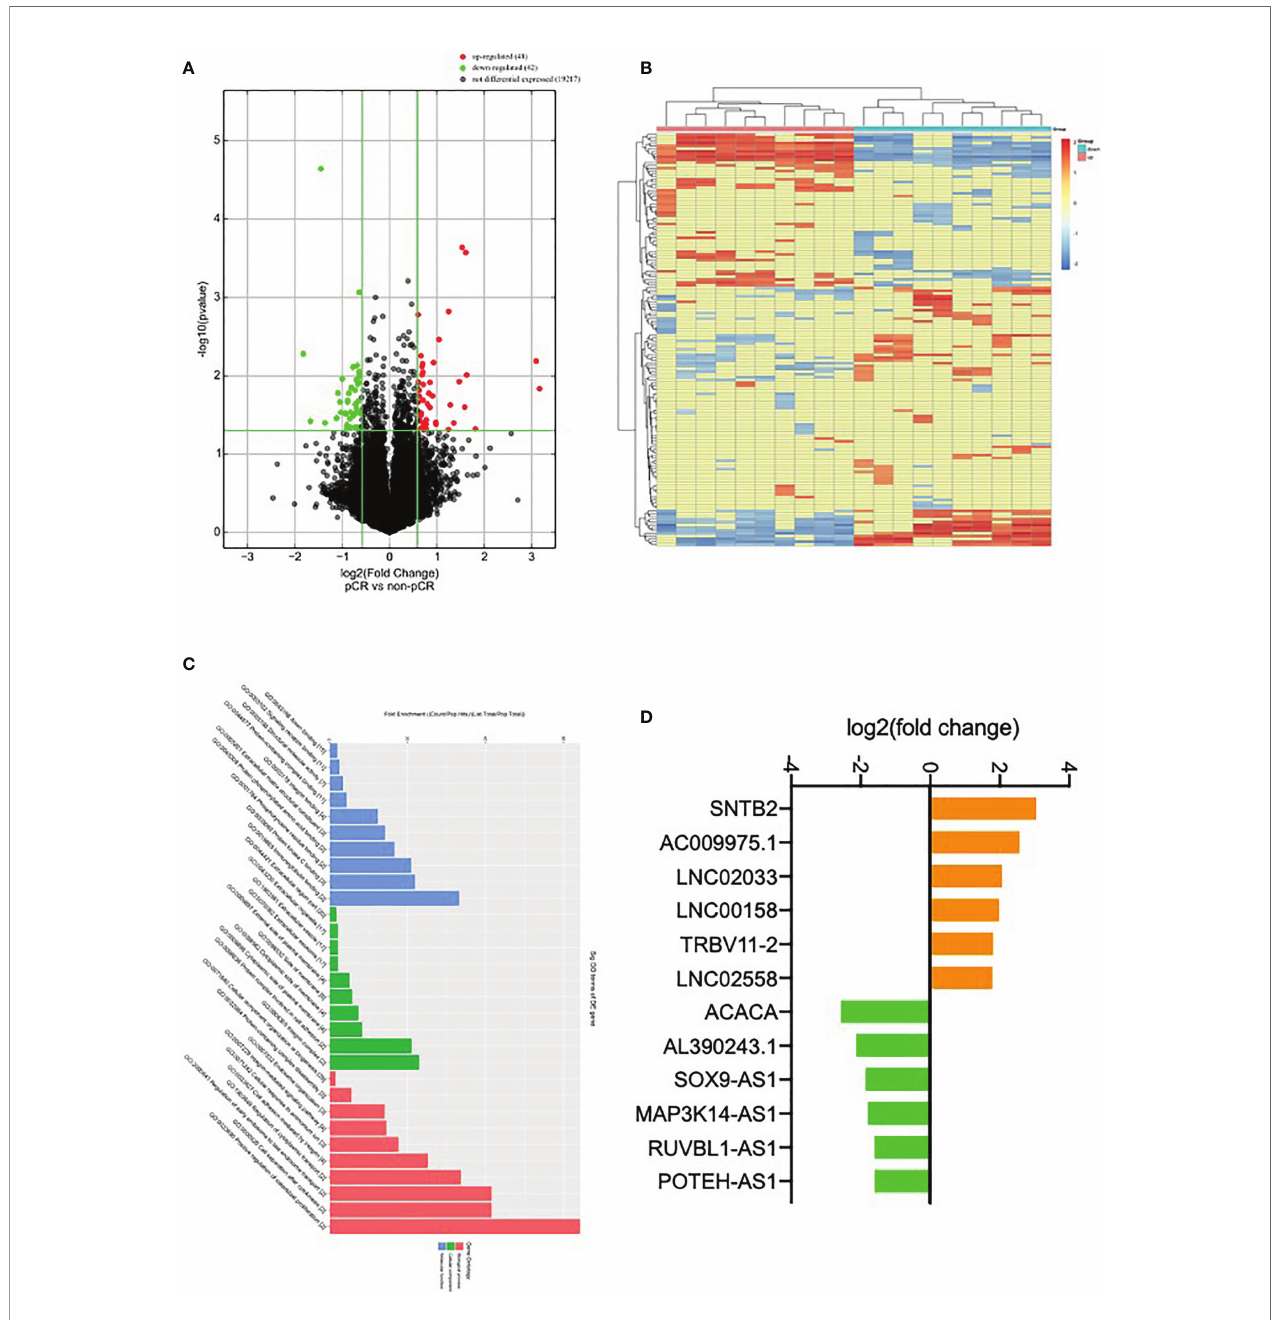
FIGURE 1 | Identi fi cation of differentially expressed lncRNA. (A) Volcano plot compared the expression fold change of lncRNA for ypT 0 N 0 and ypT + N + tissues; (B) a heat map was generated after supervised hierarchical cluster analysis. LncRNA is shown in red (upregulation) versus blue (downregulation); (C) GO analysis of lncRNA in ypT 0 N 0 and ypT + N + tissues; (D) 12 selected lncRNAs are shown in yellow (upregulation) versus green